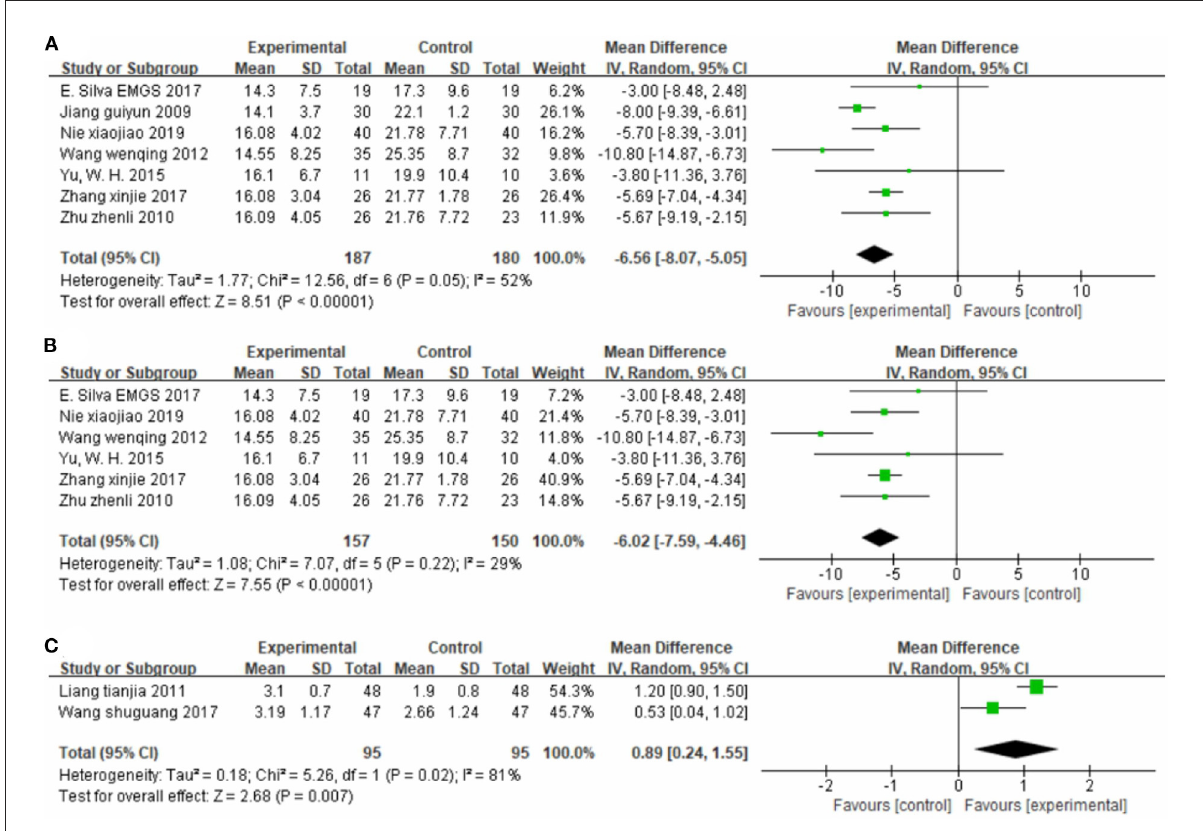
FIGURE5 Forest plot. CIMT vs. conventional physiotherapy on the timed up and go test (A,B) and functional ambulation category scale (C)